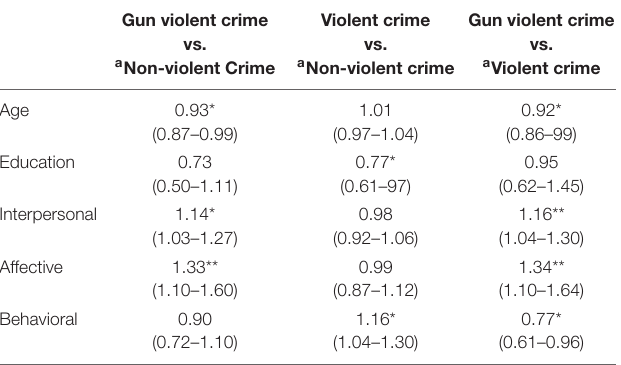
TABLE 1 | Criminal group comparisons on the 3-facet construct of psychopathy based on odds ratios (95% CI). Gun violent crime